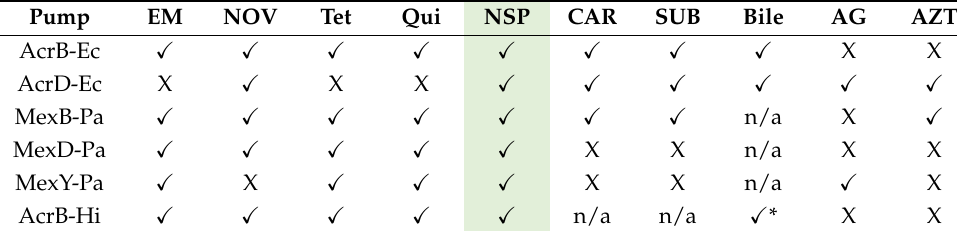
Table 8. Substrate specificities of six different